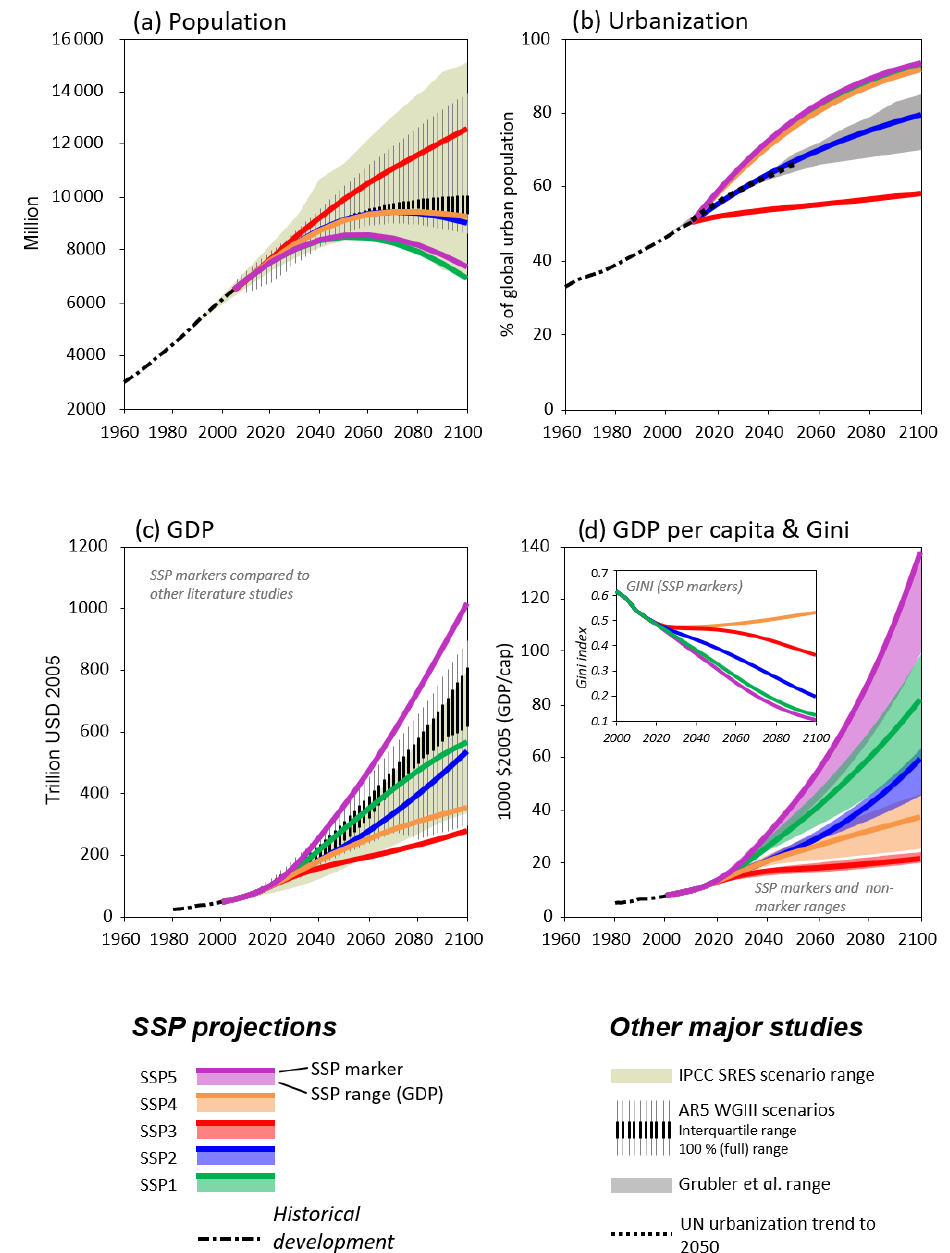
Figure A1. The primary socioeconomic assumptions associated with each SSP, including population (KC and Lutz, 2017), urbanization (Jiang and O’Neill, 2017), and GDP (Dellink et al., 2015). The figure is adapted from Riahi et al. (2017) with permission from the authors.